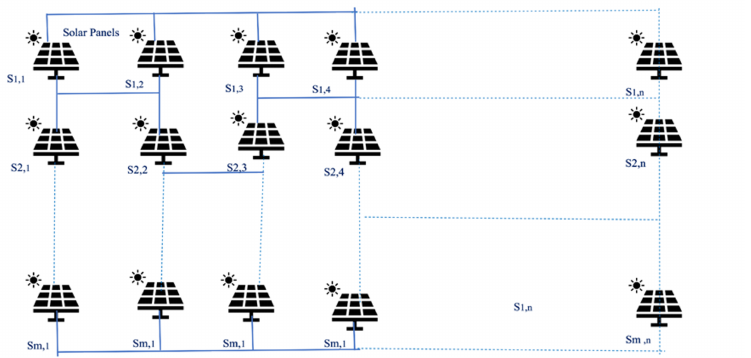
Figure 3. Bridge-linked PV panel